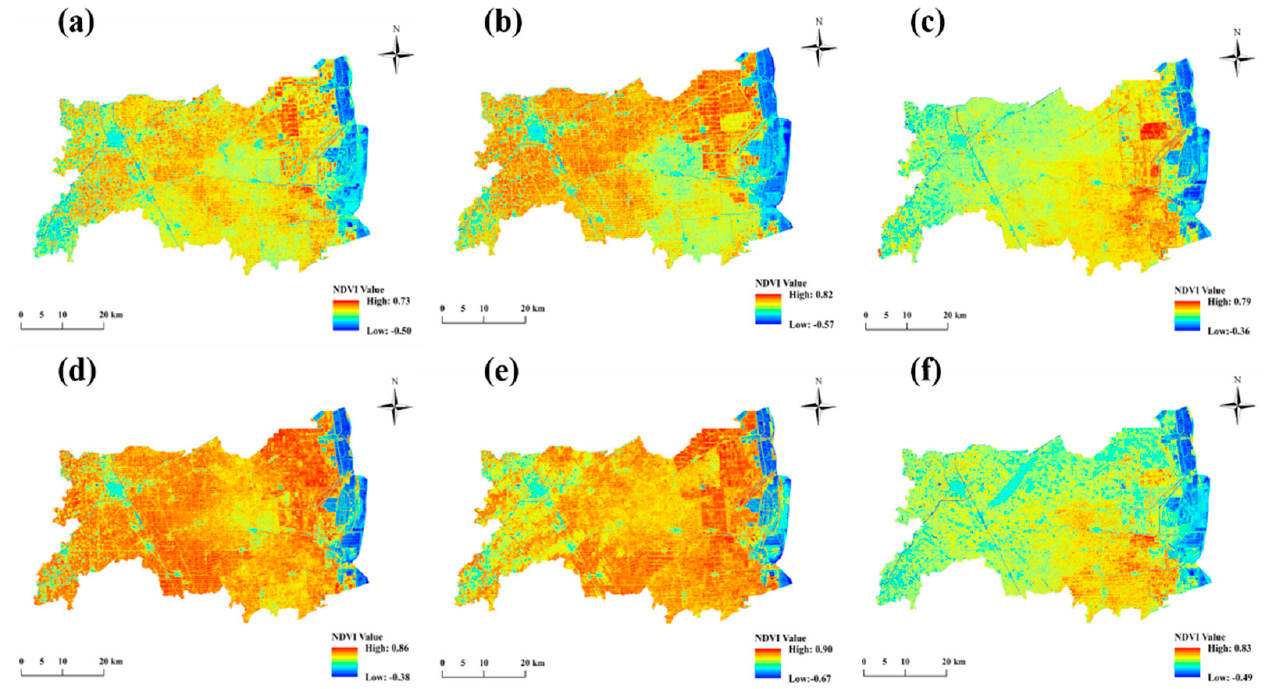
Figure 2. Diagrams showing the 2 − month average NDVI images for the study area in 2018, including ( a ) January to February, ( b ) March to April, ( c ) May to June, ( d ) July to August, ( e ) September to October, and ( f ) November to December.